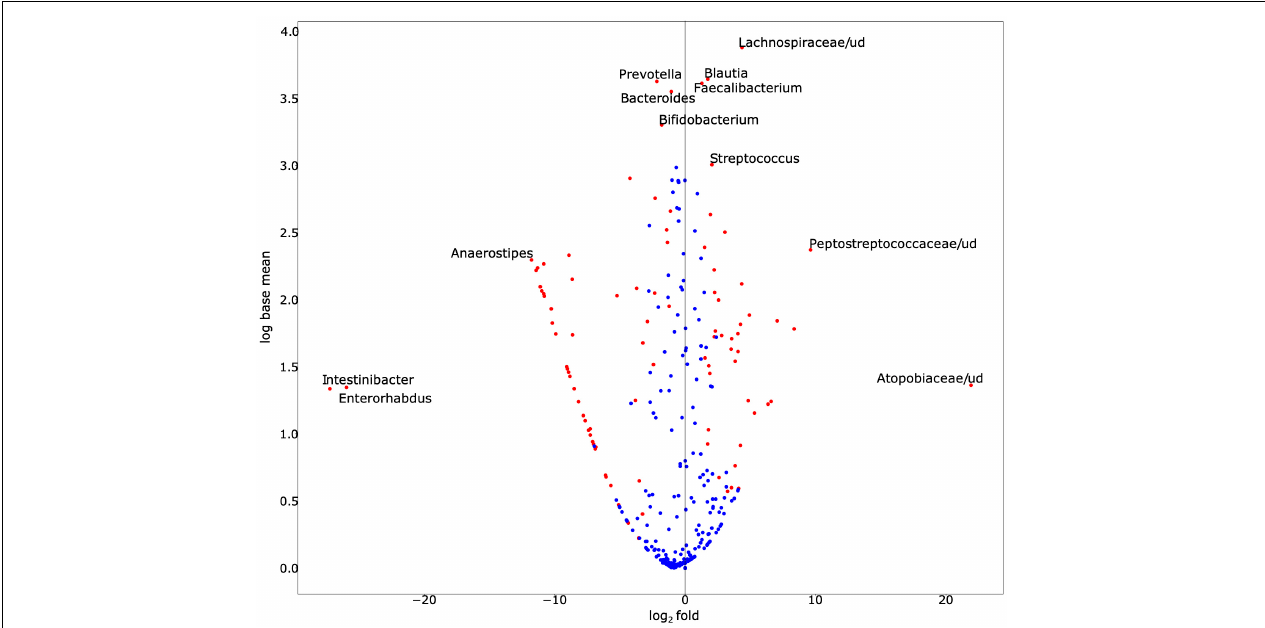
FIGURE 2 | Exploration of bacterial abundance and prevalence in SARS-CoV-2-infected and SARS-CoV-2-non-infected control groups. The volcano scatter plot of base mean abundance between both groups shows the log2 change between infected vs. non-infected samples on the horizontal axis. The vertical axis shows the abundance. Red dots indicate statistical significance after multiple testing corrections at the significance level 0.05. This figure was produced by DESeq2. While we observe that many species are significantly different, the labeled ones of interest demonstrate either especially large effect sizes or large abundances. Supplementary Table 1 demonstrates the base mean, fold change, effect size, and adjusted p -value (for gender and age-group via a likelihood ratio test) of each associated bacterial genus. Supplementary Table 2 demonstrates the total prevalence and average relative abundance of each